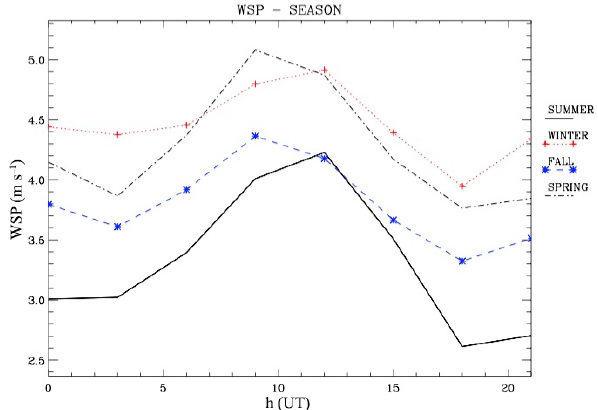
Figure 5. Averaged wind speed for the different seasons as a func- tion of the hour of the day (every 3h). The average has been com- puted grouping all the available data of the SYNOP stations for the period 1 December 2012–30 November 2013.